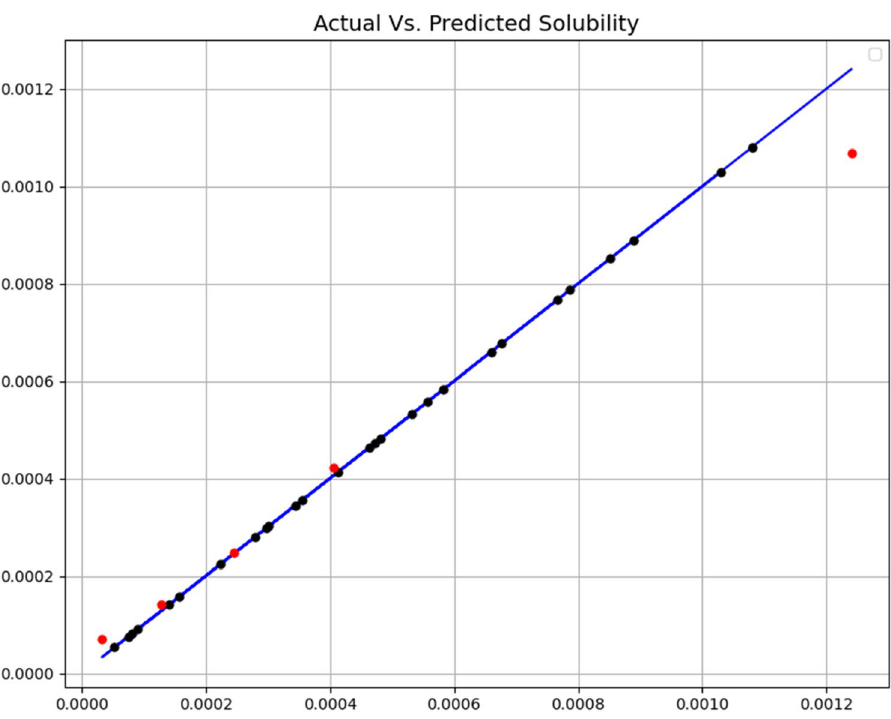
Figure 3. Expected and predicated solubility (ET